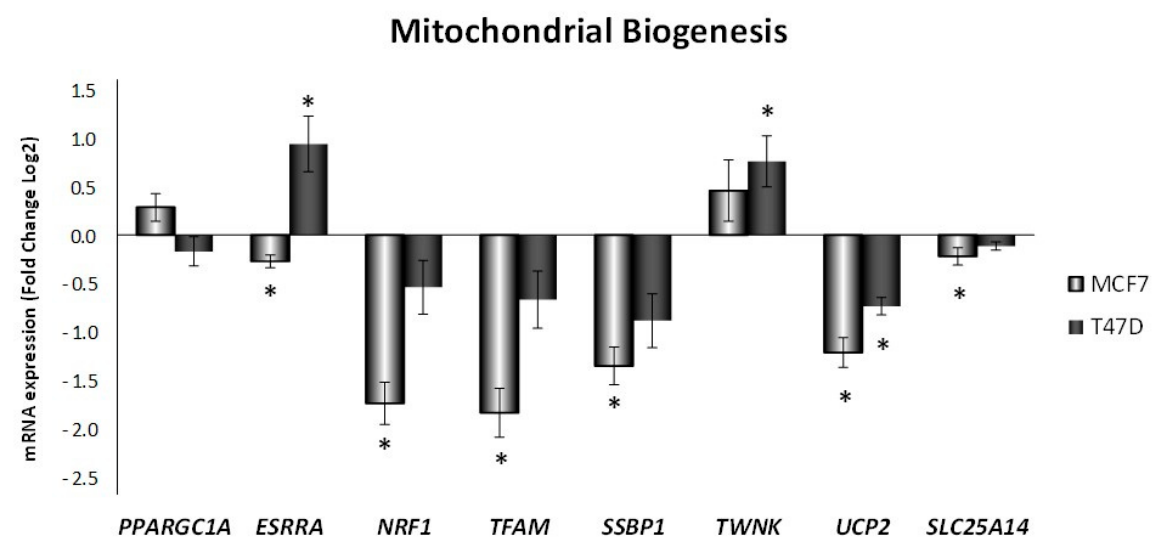
Figure 3. Obesity-related inflammation treatment modified expression of genes related to mitochondrial biogenesis in MCF7 and T47D breast cancer cell lines. PPARGC1A : peroxisome proliferator-activated receptor-gamma coactivator-1alpha; ESRRA : estrogen-related receptor alpha; NRF1 : nuclear respiratory factor 1; TFAM : mitochondrial transcription factor A; SSBP1 : mitochondrial single-strand DNA binding protein; TWNK : Twinkle mtDNA helicase; UCP2 : uncoupling protein 2; SLC25A14 : uncoupling protein 5. Breast cancer cells were incubated for 24 h with vehicle (DMSO) or ELIT. Data are represented as fold change (log2) of mRNA expression with respect to vehicle-treated cells, set at 0, of each cell line. Data represent means ± SEM ( n = 6). * Statistically significant difference between treated and vehicle-treated cells (Student’s t -test, p < 0.05).